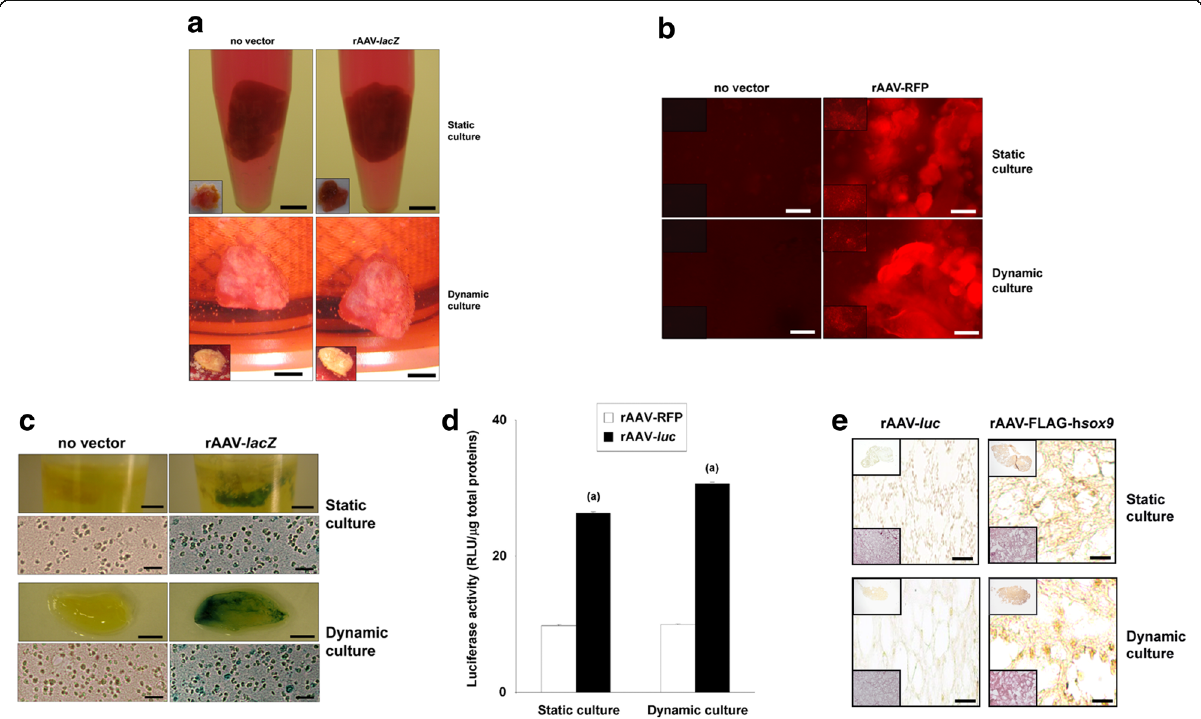
Fig. 1 Detection of transgene expression in rAAV-transduced human bone marrow aspirates in static versus dynamic culture conditions. Aspirates (150 μ l) were transduced with rAAV-RFP, rAAV- lacZ , rAAV- luc , or rAAV-FLAG-h sox9 (40 μ l each vector) or let untransduced for maintenance in dynamic or static culture conditions for up to 28 days ( n =4 independent samples tested in triplicate per vector treatment and culture condition in three bars: 1.5 cm for the static cultures and 2 cm for the dynamic cultures; insets: day 28), b Detection of RFP expression by live fluorescence (day 21, scale bars: 50 μ m; top insets: day 7; bottom insets: day 28), c detection of lacZ expression (day 21) by X-Gal staining (macroscopic views, scale bars: 1.5 cm for the static cultures and 2 cm for the dynamic cultures) and following histological processing of the samples (magnification x20, scale bars: 100 μ m, SOX9 (day 28, magnification x40, scale bars: 40 μ m; top insets: complete section, magnification x4; bottom insets: H&E staining, magnification x40;